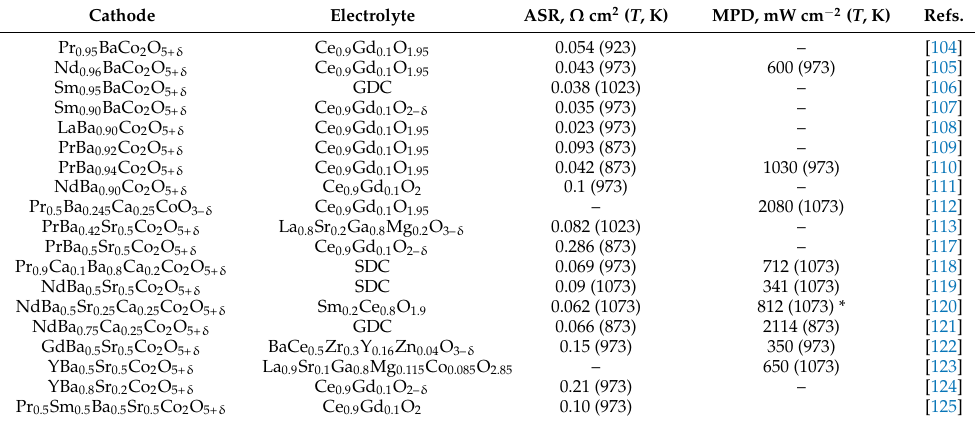
Table 4. Performance (ASR: area specific resistance, MPD: maximal power density) of SOFCs based on A-site deficient and A-site substituted REE-barium layered double cobaltites. Cathode